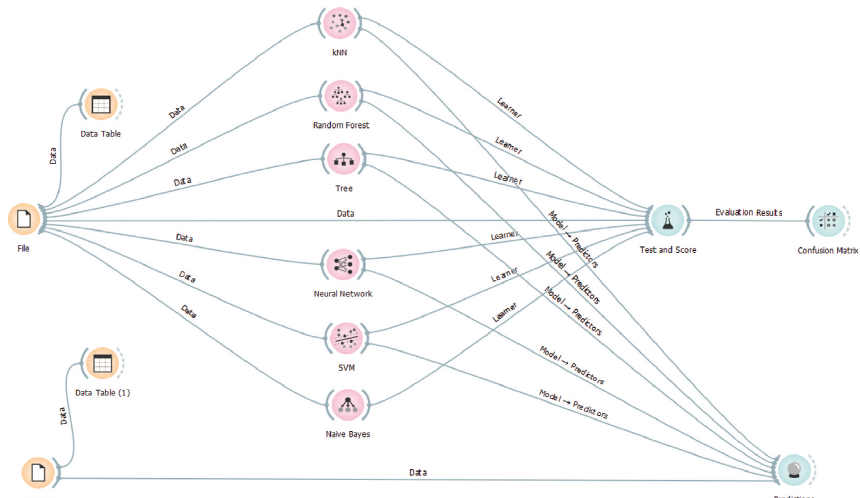
Figure 14: Orange tool workflow diagram for evaluating the results of different ML algorithms.